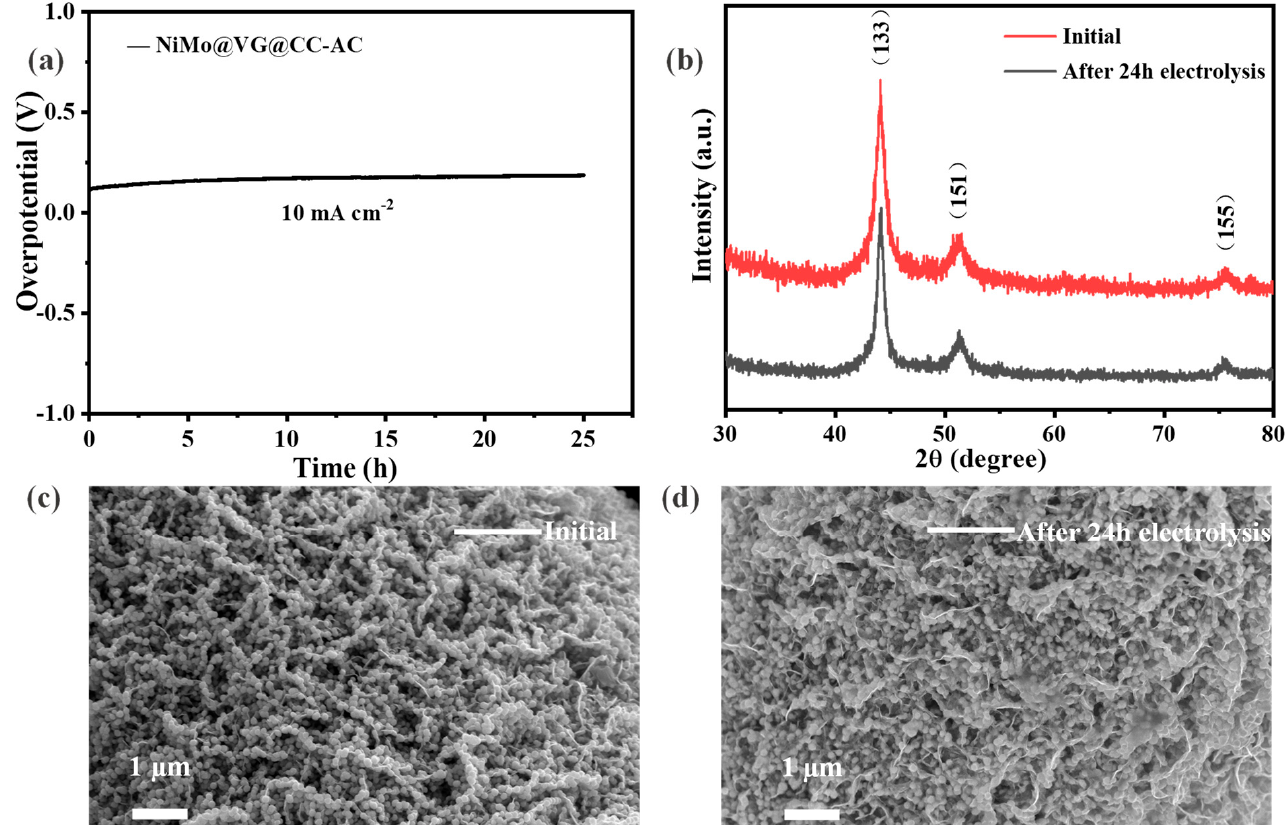
Figure 4. Stability test of NiMo@VG@CC-AC at 10 mA cm − 2 for 24 h. ( a ) Compared LSV polarization curves at the scan rate of 5 mV s − 1 and long-term cycling stability performance, ( b ) Compared XRD patterns initial and after 24 h electrolysis, SEM images of NiMo@VG@CC-AC initial ( c ) and after ( d ) stability test.